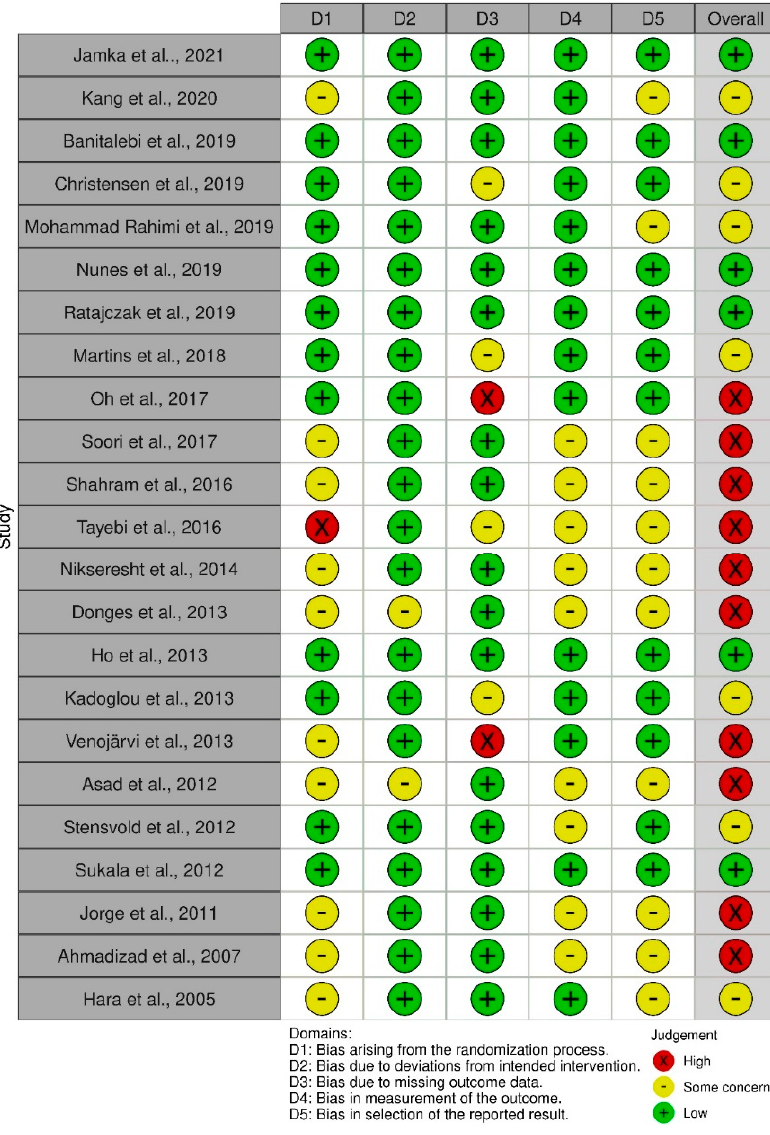
Figure 8. Traffic − light plot of the risk of bias